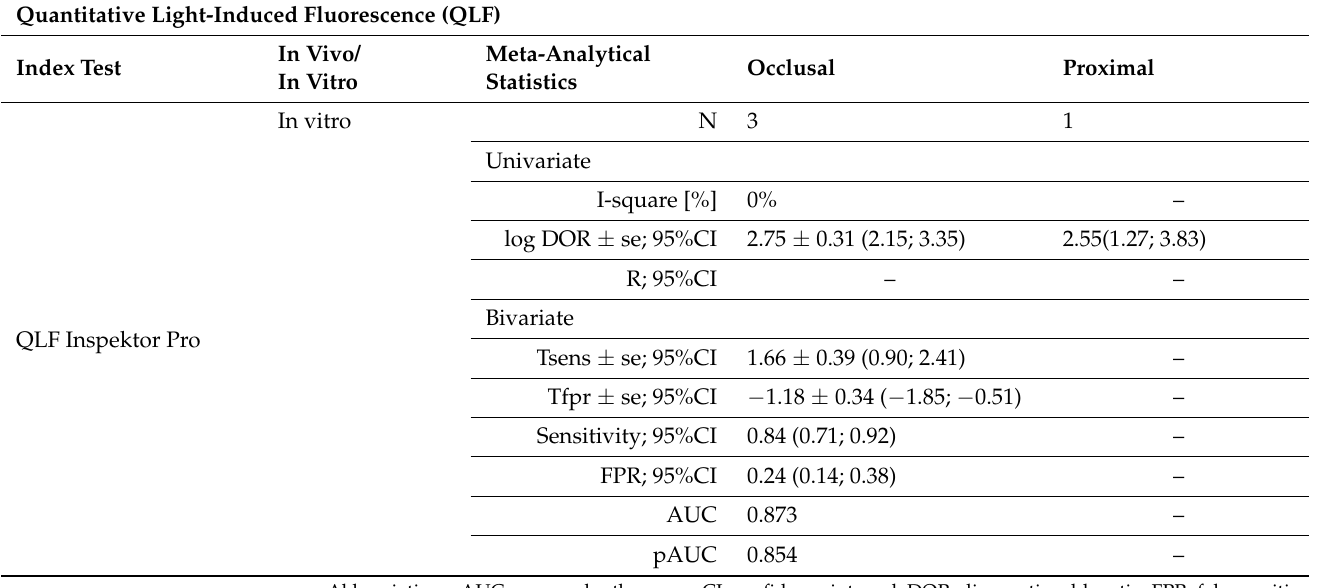
Table 9. Meta-analytical results for the quantitative light-induced fluorescence (QLF) Inspektor Pro